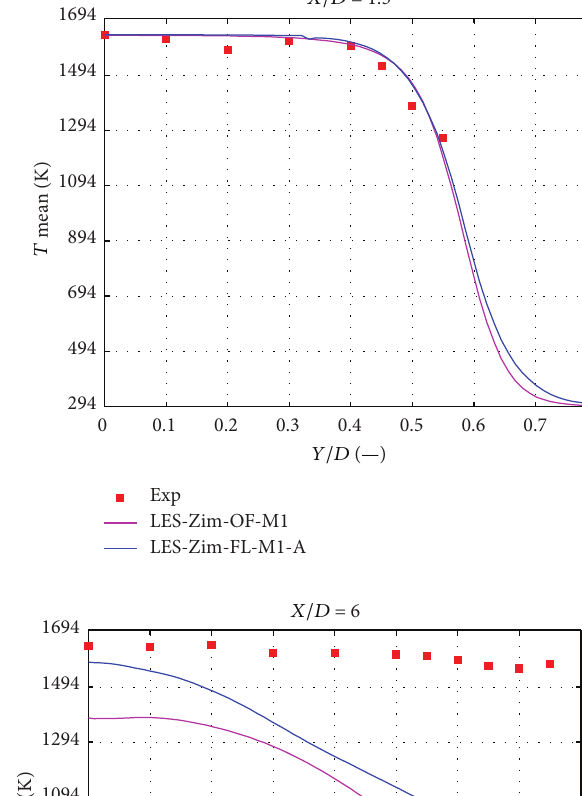
LES performed with Zimont turbulent flame speed clo- sure show that if the grid clustering is based on aerodynamic and RANS flame thickness considerations, it is necessary to tune model constant 𝐴 to achieve a complete combustion at the exit of the burner. Solutions obtained with Fluent and OpenFOAM using nominally same models are equivalent in terms of mean profiles at least up to 𝑋/𝐷 < 2 . Main differences are limited to the near wall flame behavior and the flame brush thickness which are, respectively, due to the employed wall functions and the advective interpolation scheme for the progress variable